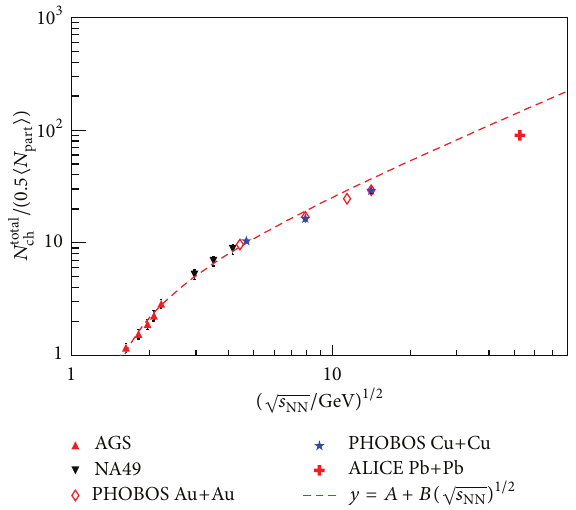
Figure 24: Total charged particle multiplicity per participant pair as Figure 23: Total charged particle multiplicity per participant pair . The data points are fitted with the parametrized a function of √𝑠 / GeV ) 1/2 . The data points are fitted with the as a function of (√𝑠 NN NN form of (24), which is shown by the dotted line. The continuous line parametrized form of (21), which is shown by the dotted line. shows a comparison with a power law form of energy of trapezoidal rule given by (19) and (20) underestimates the 𝑁 total of Pb+Pb collisions at √𝑠 = 2.76 TeV measured by the NN ch /𝑑𝜂 distribution ALICE experiment. This is because the 𝑑𝑁 ch of Pb+Pb data has a dip which in principle deviates from a trapezoidal shape.